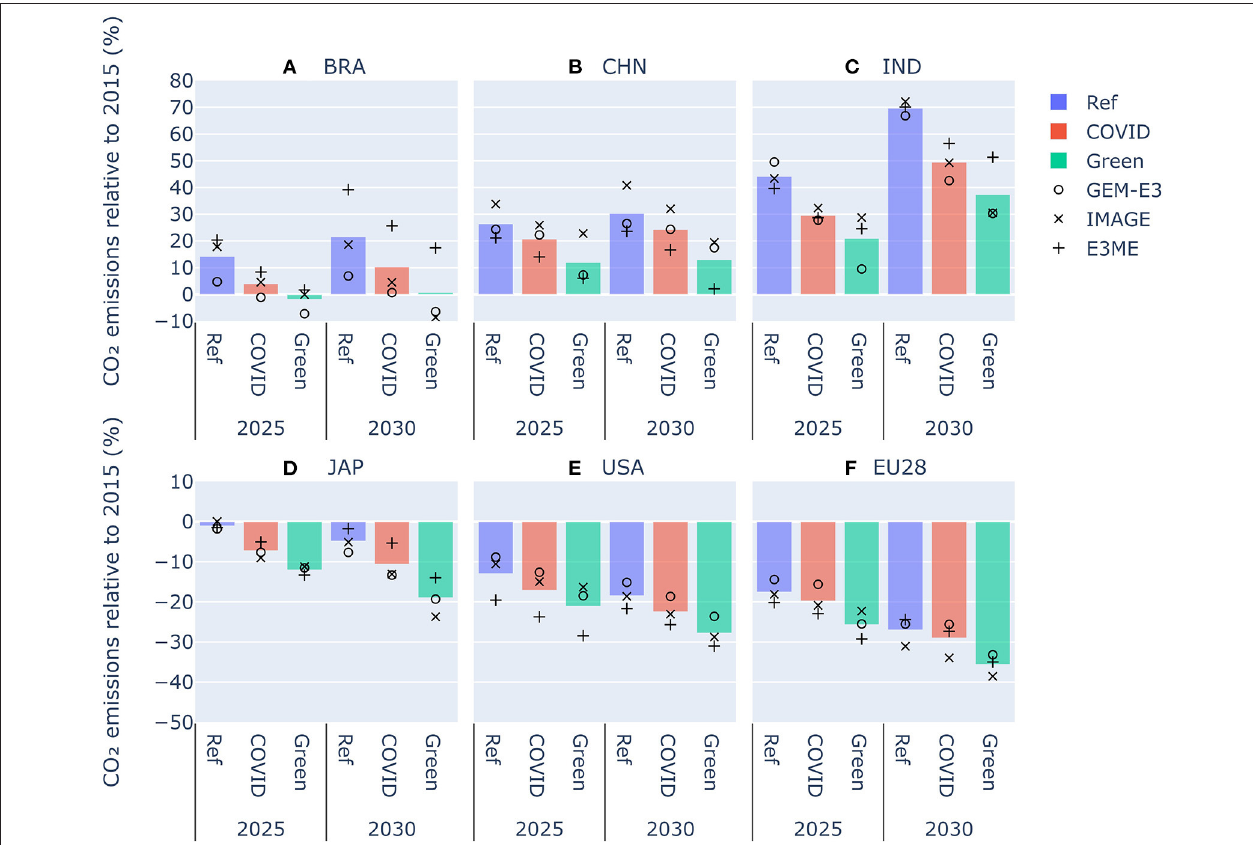
FIGURE 2 | CO 2 emission projections for major emitting regions - (A) Brazil, (B) China, (C) India, (D) Japan, (E) USA, and (F) EU28. CO 2 emissions from energy and industrial processes, relative to 2015 (%), per major emitting region (panel), for 2025 and 2030 (x-axis), for all scenarios (color). Symbols indicate individual model results. The bars indicate model mean and were added for reporting